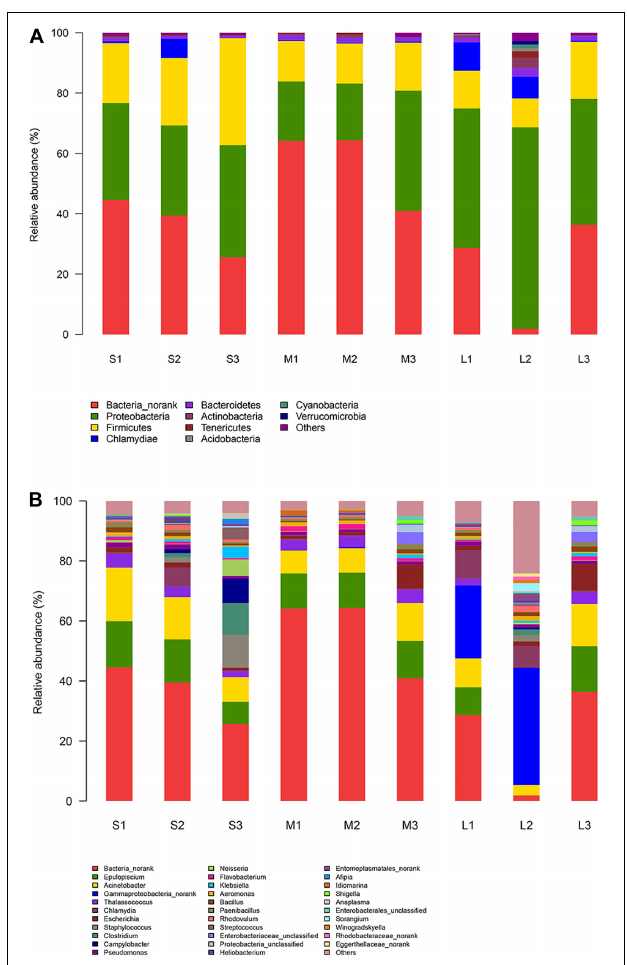
FIGURE 4 | Relative abundance of the microbiota in the stomach content samples. (A) Relative abundance of the microbiota at the phylum level. (B) Relative abundance of the microbiomes at the genus level.